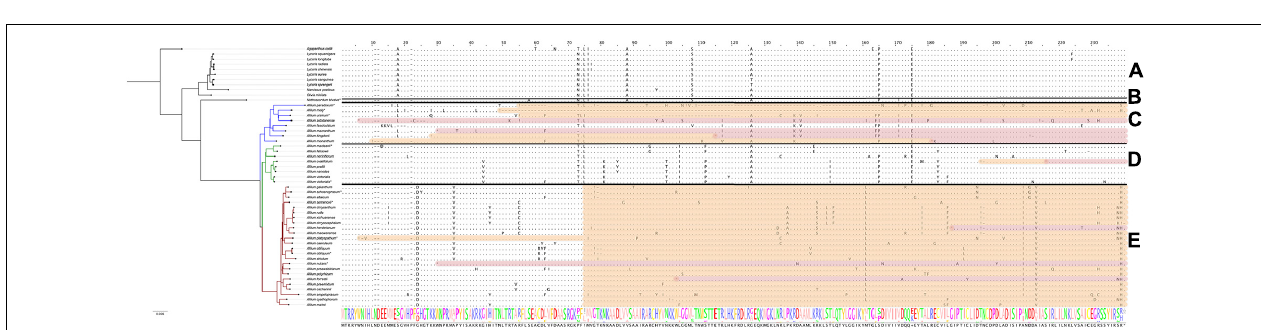
FIGURE 3 | Protein sequence alignment of the plastid 30S ribosomal protein S2 encoded by rps2 genes. Àll species are sorted by phylogenetic tree: the first evolutionary line of Allium is blue, the second is green, the third is red and the remaining species are black. Species sequenced by our group are marked with *. (A) Shows Agapanthoideae and Amaryllidoideae subfamily species; (B) shows Nothoscordum bivalve as an outgroup for Allium genus; (C) shows the first evolutionary line Allium species; (D) —the second and (E) —the third. Non-conserved AA positions are highlighted as letters and conserved as dots. The whole AA sequence is shown as a normalized alignment logo below. Possible frameshifts are shown as ! and stop codons as *. Damaged sequences are highlighted in peach color in case of frameshift and in purple in case of stop codon. Colored sequences may be assumed to be a